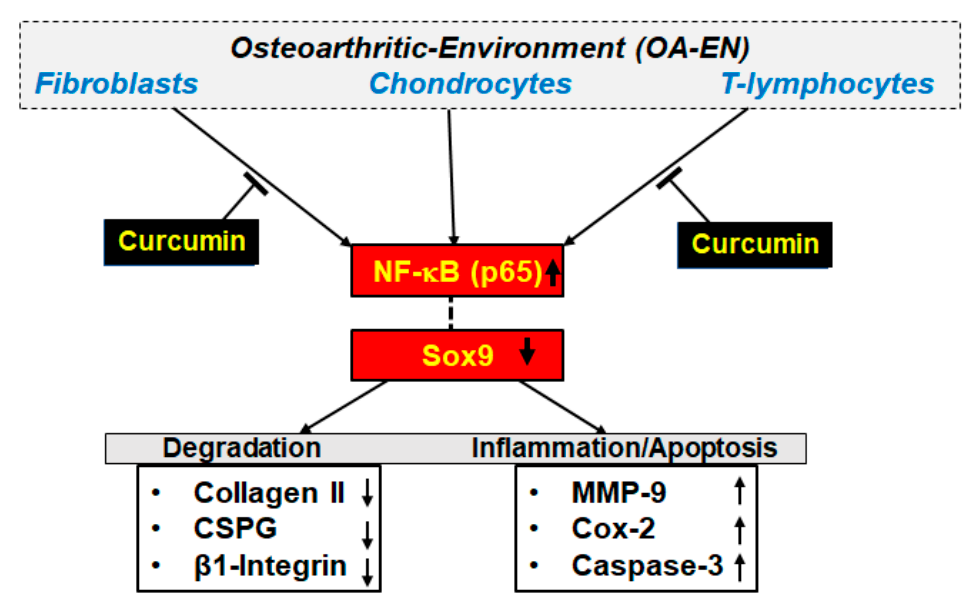
Figure 7. A schematic diagram shows how curcumin modulates the microenvironment leading to osteoarthritis through suppression of inflammatory pathways.